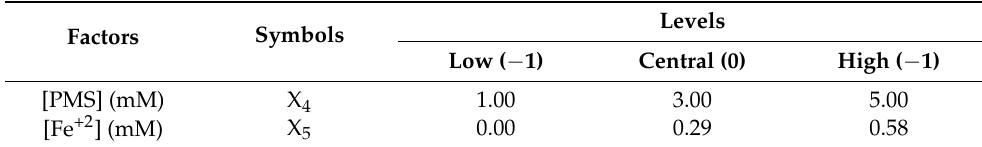
Table 2. Ranges and levels of independent variables for CCD on